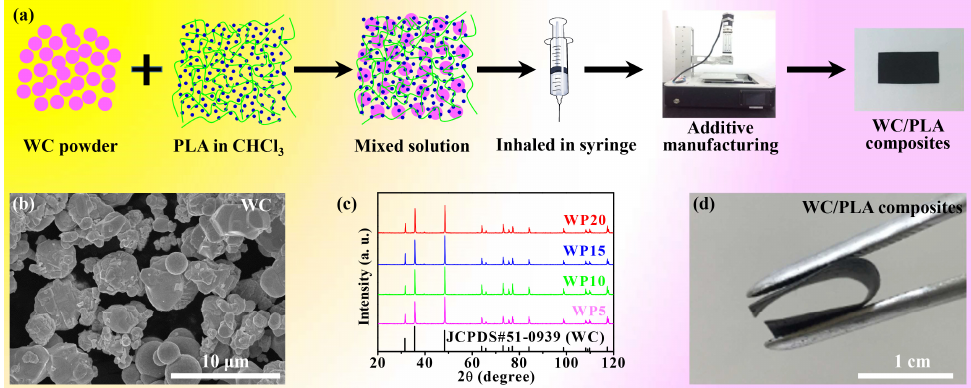
Figure 1. Schematic of the fabrication process of the WC/PLA thermoelectric composites ( a ), SEM image of tungsten carbide (WC) ( b ), XRD patterns of tungsten carbide/polylactic acid (WC/PLA) composites with different WC loadings ( c ), and the flexible display digital photo of the WP5 ( d ).